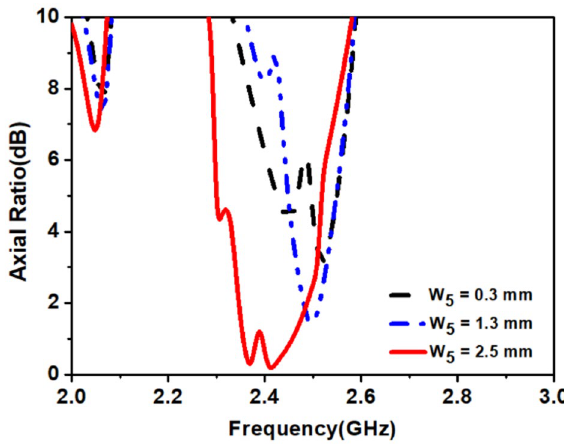
Figure 12. Effect of width ( w 5 ) of Stub-3 on axial- ratio.